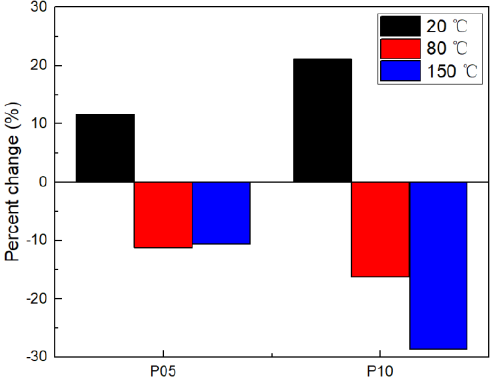
Figure 12. Percent change of peak stress compared with P0.